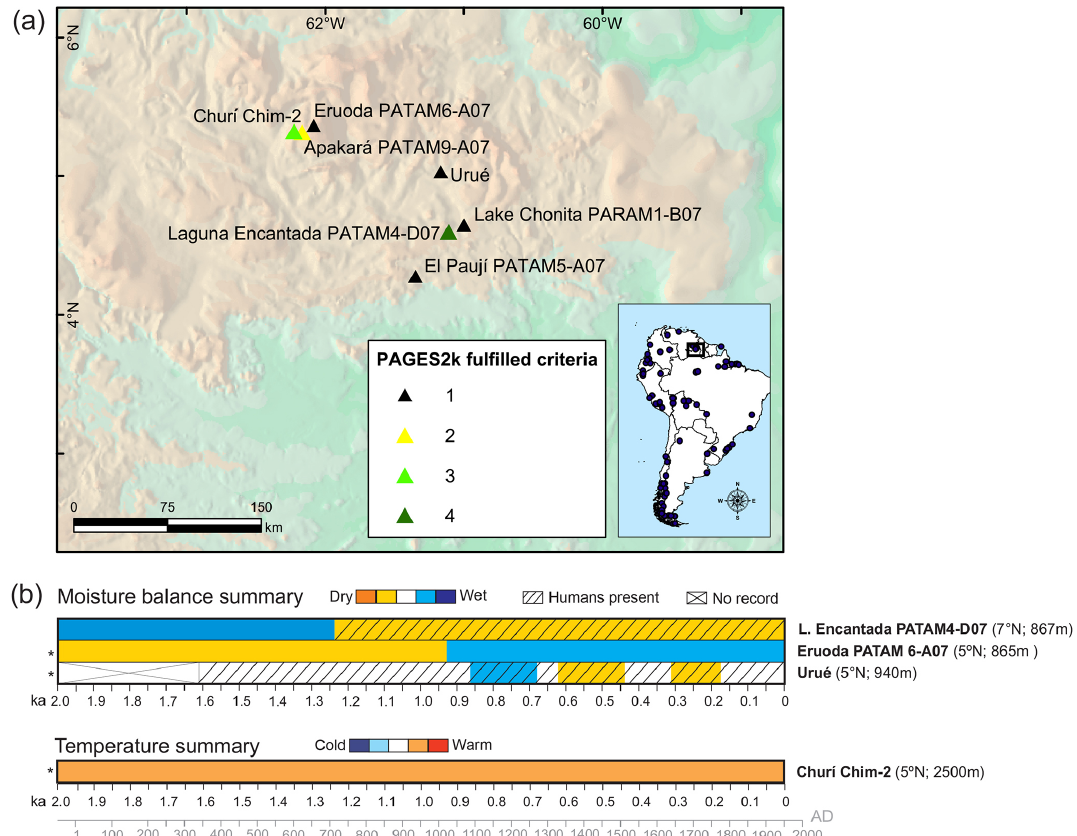
Figure 7. Panel (a) : map showing the pollen records discussed in the Venezuelan Guayana highlands and uplands and the number of PAGES- 2k criteria these records fulfill. Panel (b) : summary of moisture balance and temperature including human interference for the pollen records discussed. Not all records are suitable to derive both a moisture and a temperature signal. Climate and human presence are shown overlapping when the pollen record is not conclusive regarding the derived signal. Records fulfilling one or two criteria indicated by